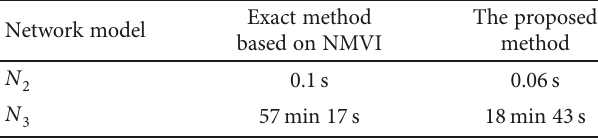
Table 5: Computing time for reliability evaluation. Network